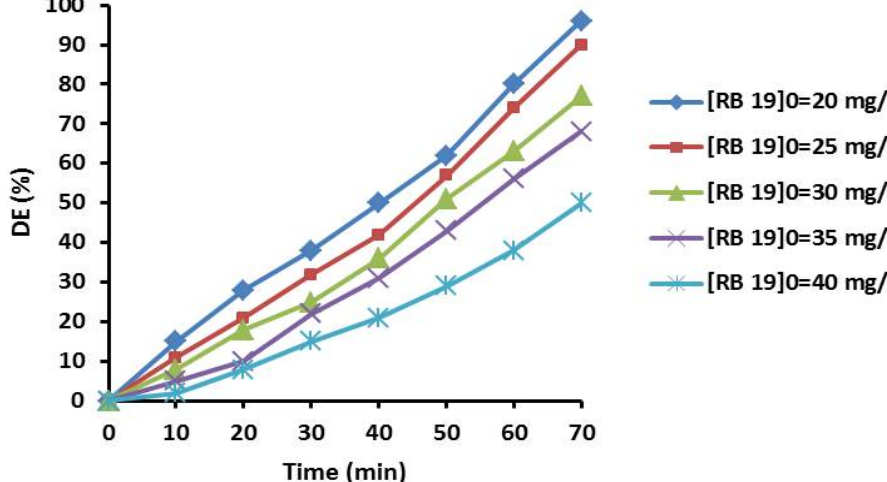
Figure 15. RB 19 concentration influence on degradation efficiency, [Catalyst] = 1.25 g/L, pH = 6.